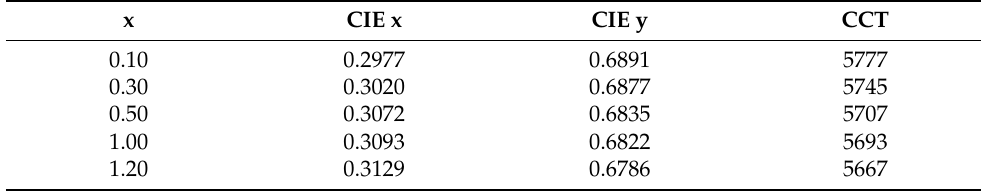
Table 5. Chromaticity coordinates ( x , y ) for (ZrO 2 ) 90 (Y 2 O 3 ) 10 − x (Ho 2 O 3 ) x